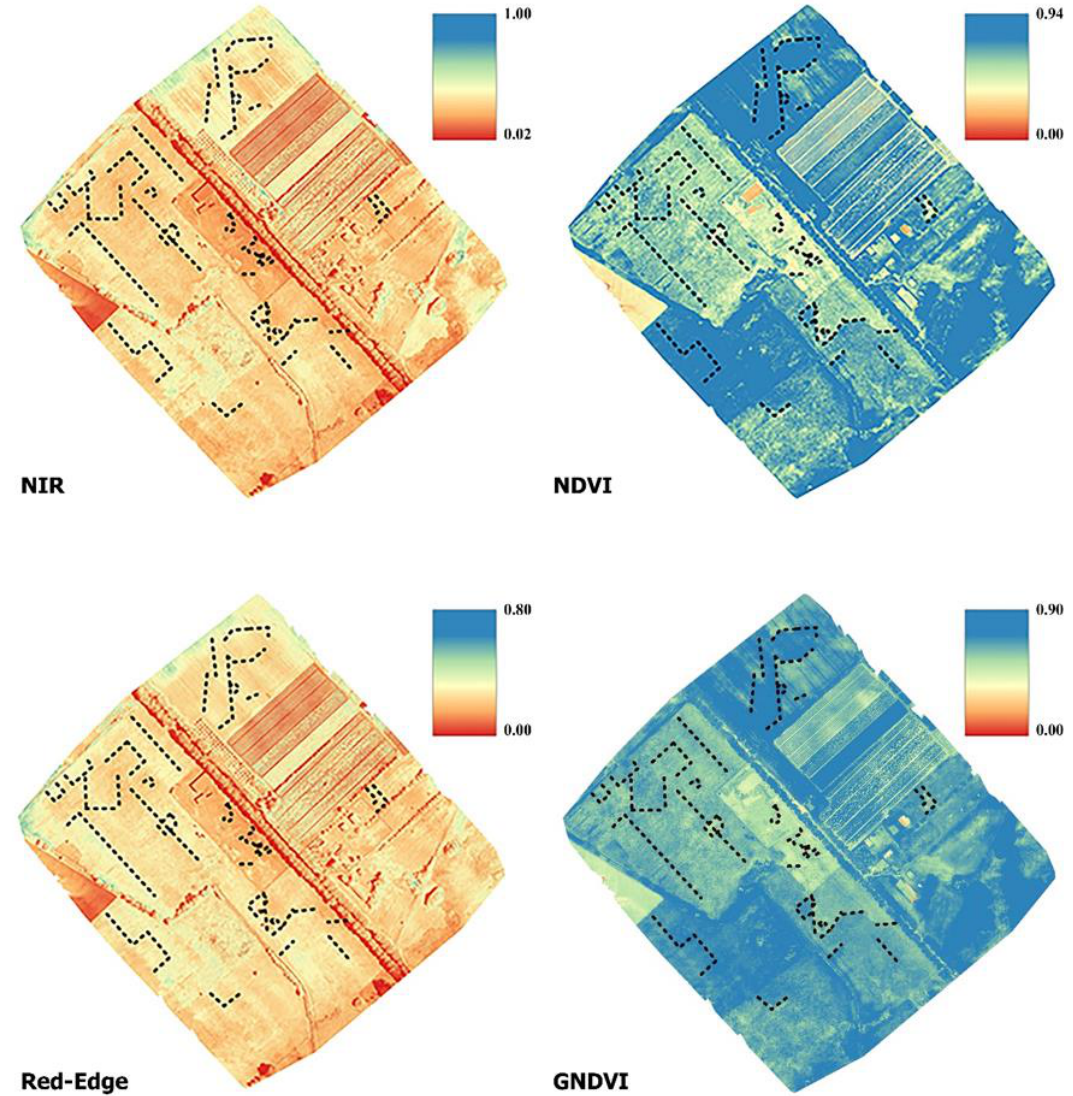
Figure 13. Multispectral maps and detected anomalies (black dotted lines).